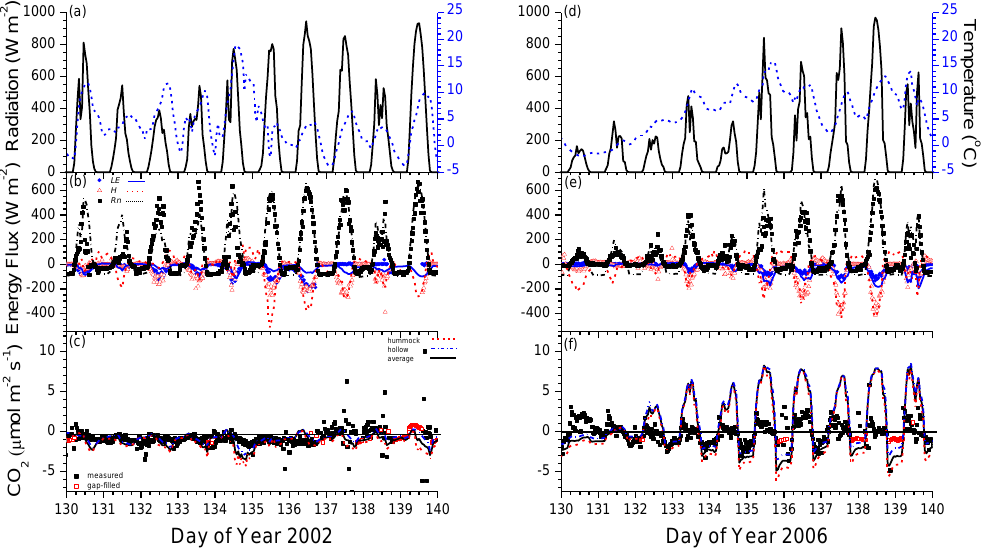
Fig. 3. Radiation and air temperature, energy and CO 2 fluxes measured (symbols) and modelled (lines) from DOY 131 to 140 with high water table in 2002 (0.0m in Fig. 2) and lower water table in 2006 (0.2m in Fig. 2). Positive values represent downward fluxes, negative values represent upward fluxes.